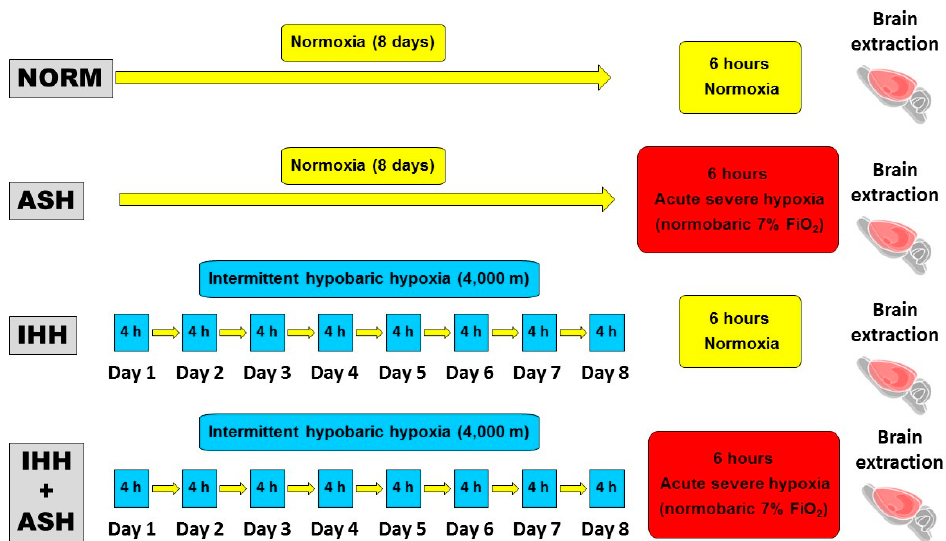
Figure 6. Experimental design and hypoxia exposure protocols. Animal experimental groups are abbreviated as NOR (normoxic), maintained at sea level conditions for the whole experiment; ASH (acute severe hypoxia), exposed to normobaric hypoxia at 7% O 2 for a single 6 h continuous session; IHH (intermittent hypobaric hypoxia) exposed to hypobaric hypoxia (4000 m) for 8 consecutive days for 4 h sessions per day; and IHH+ASH, exposed to the intermittent hypobaric hypoxia protocol followed by a single session of acute normobaric hypoxia. Brain extraction was carried out after 6 h of normoxia in NOR and IHH or immediately after 6 h of acute hypoxia in ASH and HII+ASH. Yellow boxes and arrows indicate time spent in normoxia; red boxes are acute normobaric hypoxia sessions, and blue boxes time spent in hypobaric hypoxia.